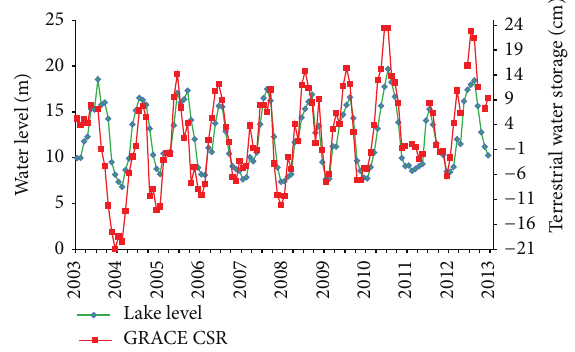
Figure 4: Monthly variations of lake level and TWS derived from GRACE CSR between 2003 and 2012.